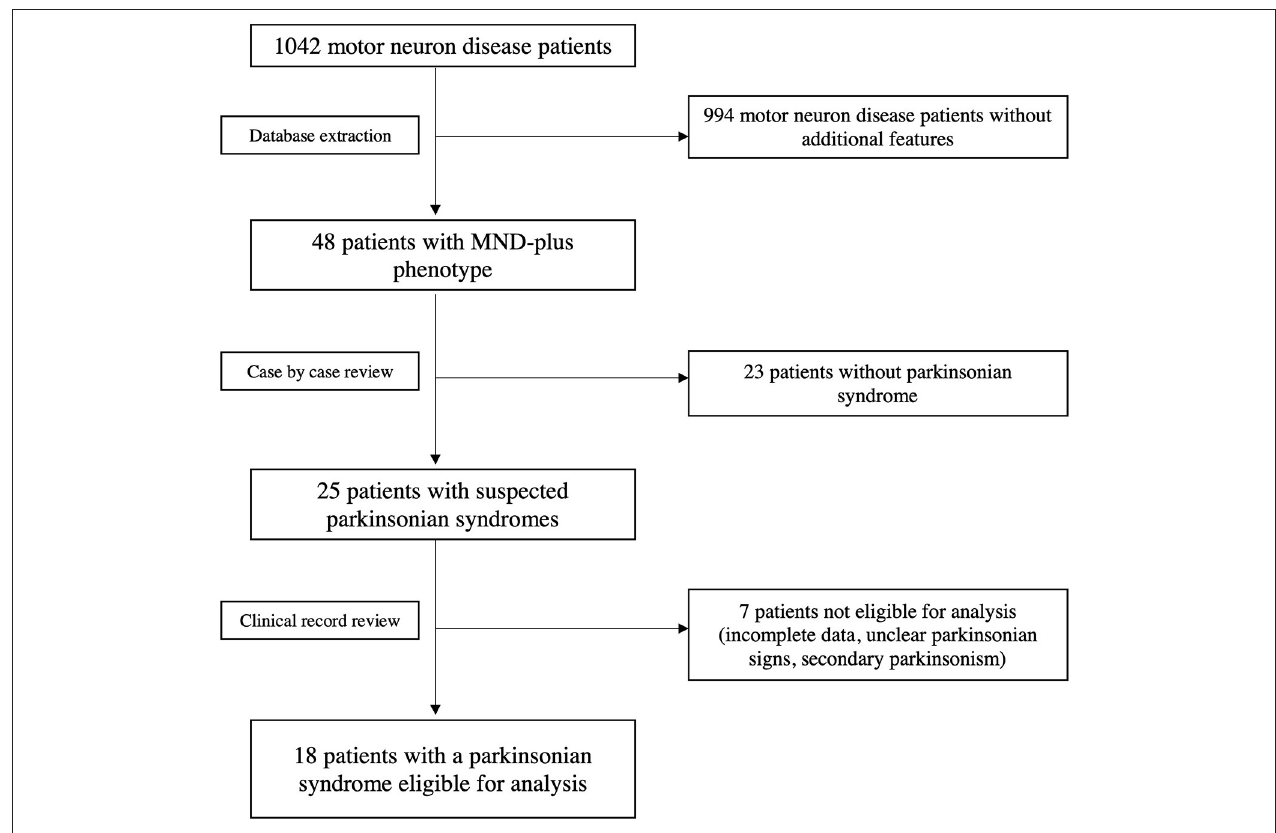
FIGURE 1 | Flow-chart showing database extraction and selection of patients with overlapping MND and primary parkinsonian